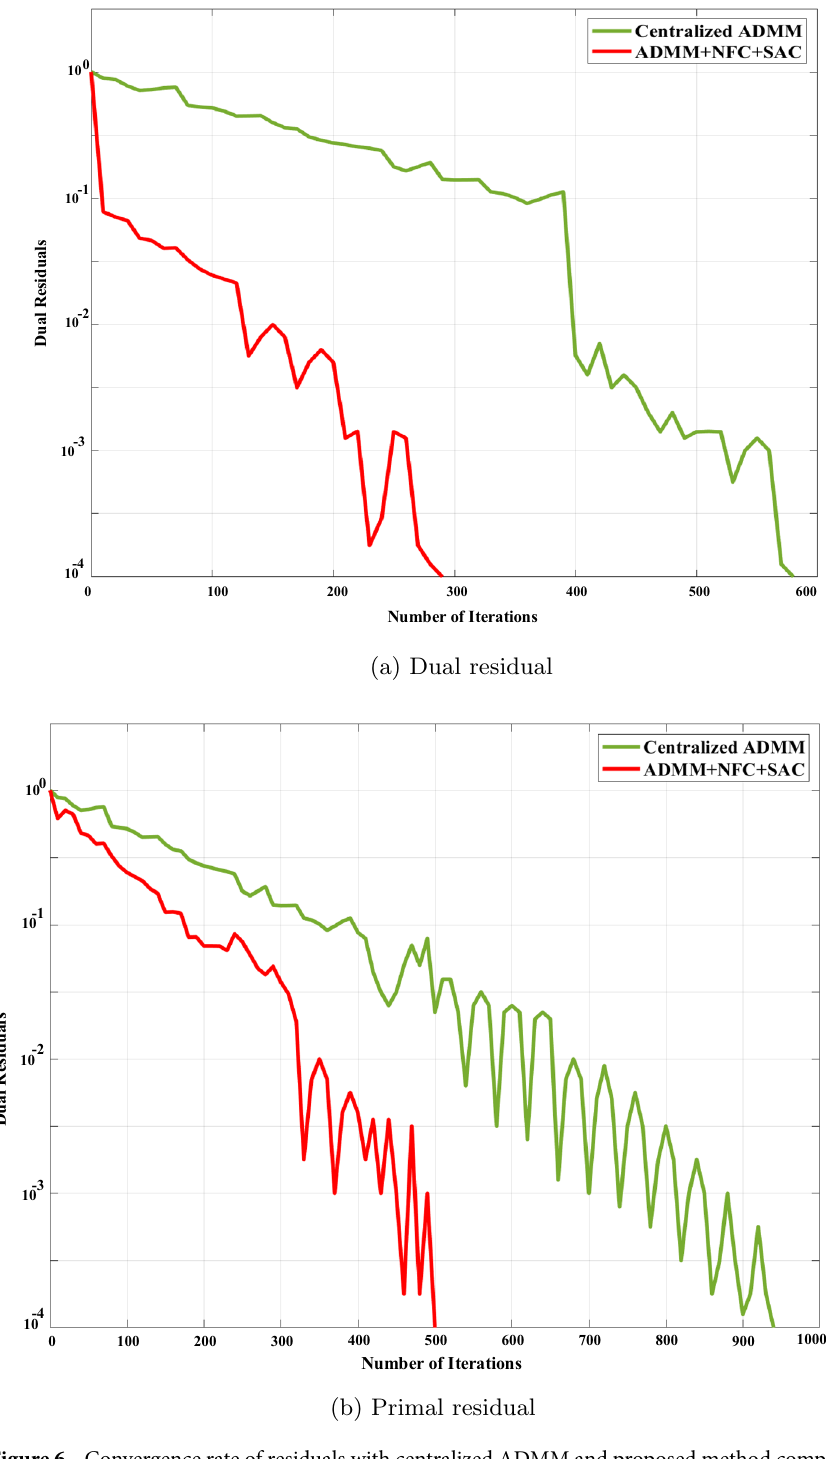
Figure 6. Convergence rate of residuals with centralized ADMM and proposed method